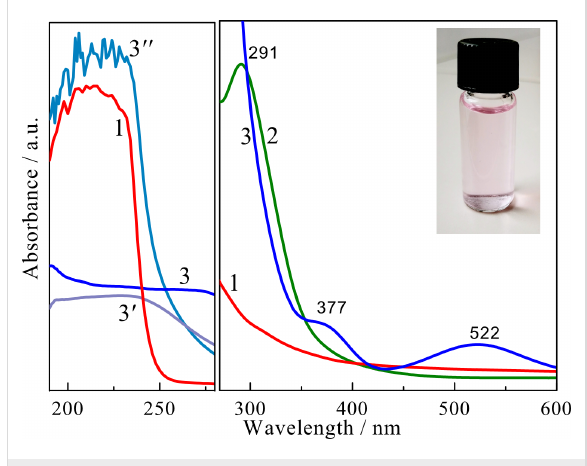
Figure 3: Absorption spectra of methionine (1), tetrachlorauric acid (2) and reddish-pink colored solution of gold species (inset) collected from the CoFe 2 O 4 @Met–Au nanoparticles initially (3) and after dilution to one half (3 ′ ) and to on quarter (3 ″ ).